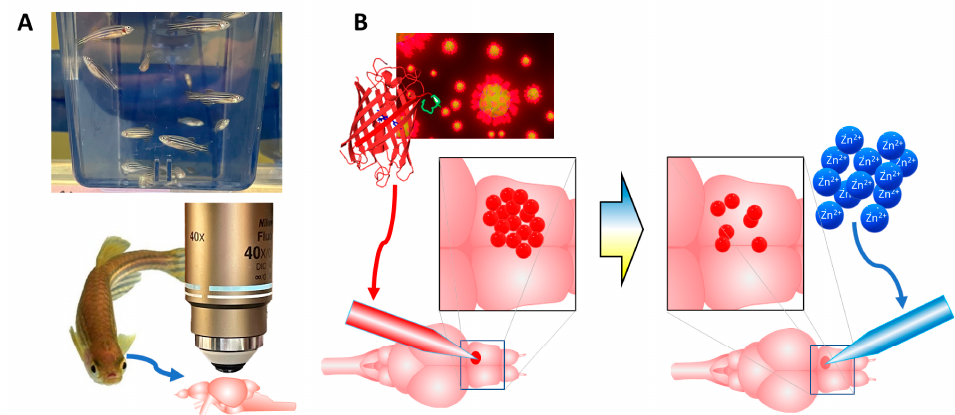
Figure 1. Schematic diagram of the overall experimental paradigm. ( A ), Live, whole brains from zebrafish were harvested for microscopy imaging. ( B ), Bionanoprobes (red balls) were delivered to specific locations in the brain with a picospritzer. Next, exogenous Zn 2+ ions (blue balls) were delivered though a separate capillary to induce quenching. The delivery of the bionanoprobes and Zn 2+ was imaged with conventional and 2PE fluorescence microscopy. Credit for image of individual zebrafish: David Dohnal/Shutterstock.com.